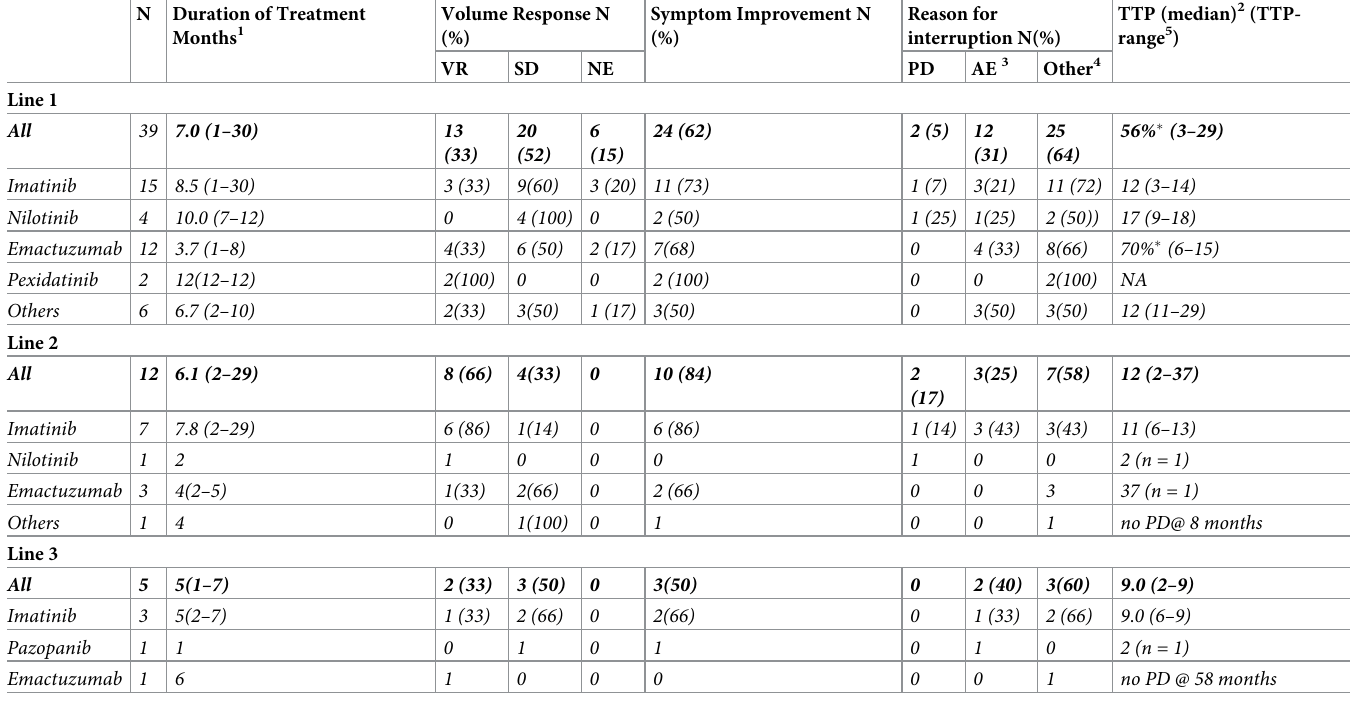
Table 2. Description of the lines of